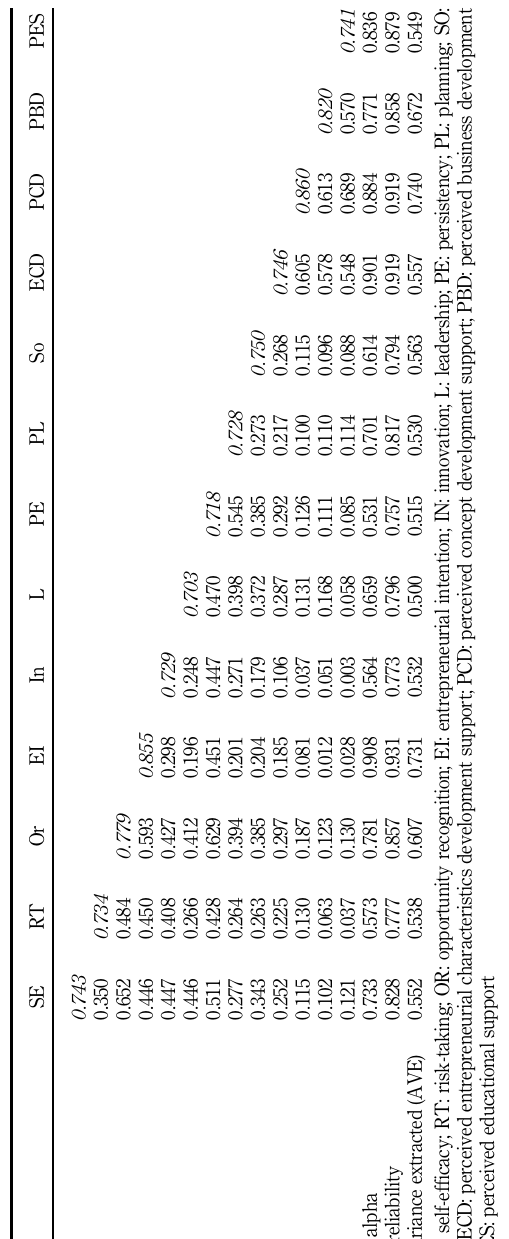
Table 2. Summary of the evaluation of measurement